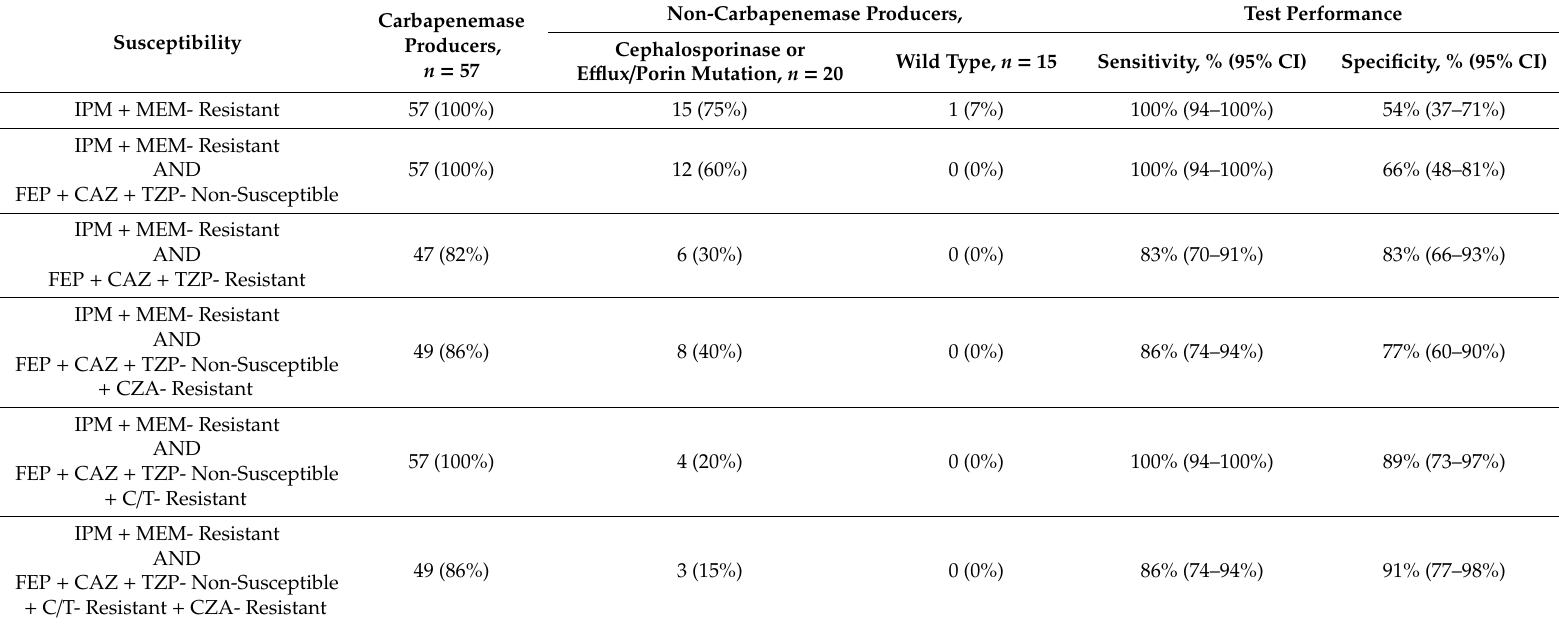
Table 1. Characteristics of the challenge set of 92 P. aeruginosa isolates utilized in algorithm